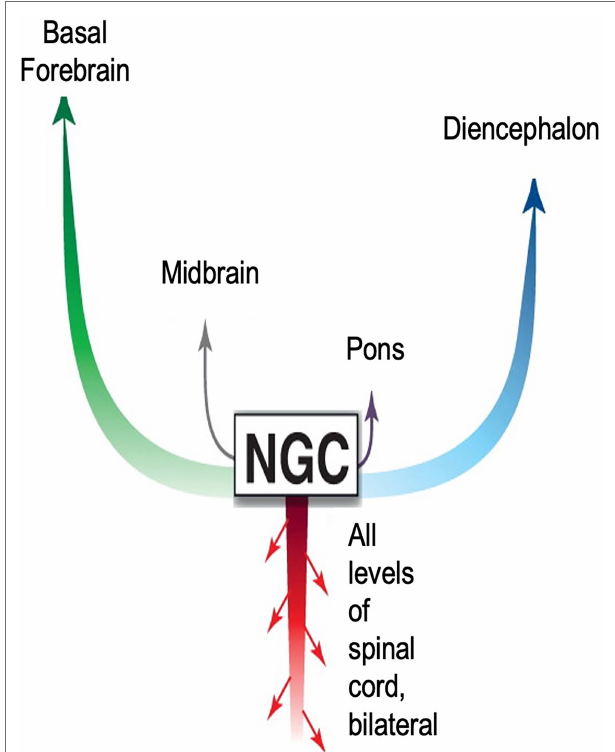
FIGURE 8 | Diagram accentuating importance of CNS signaling pathways from the nucleus reticularis gigantocellularis (NGC) to survival movements and behavior . The NGC is located in the reticulospinal tract of the brainstem. It consists of giant pairs of monosynaptic command neurons that respond to glutamatergic stimuli. The NGC form a “first response” network that transmits novel information from the environment to all parts of the body. The network is very similar in form and function to those found in reptiles and fish. As with nearly all theoretical models describing signaling pathways regulating emotions, this model emphasizes ascending pathways to higher brain centers. Descending pathways are limited to the spinal cord. Missing entirely is the ANS neurohormonal pathway to the entire body via cardiovascular circulation. Adapted with permission from Pfaff et al.